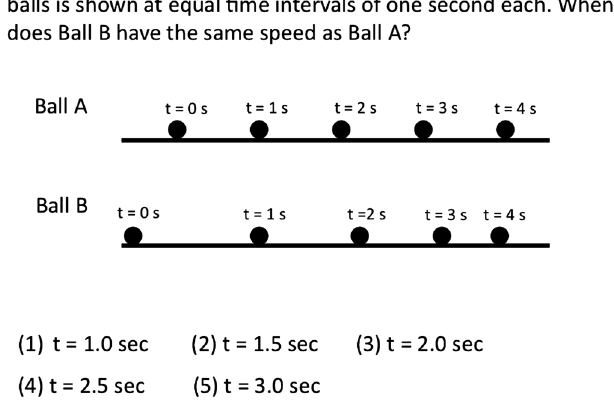
FIG. 8. Problem 4 used in studies 1 and